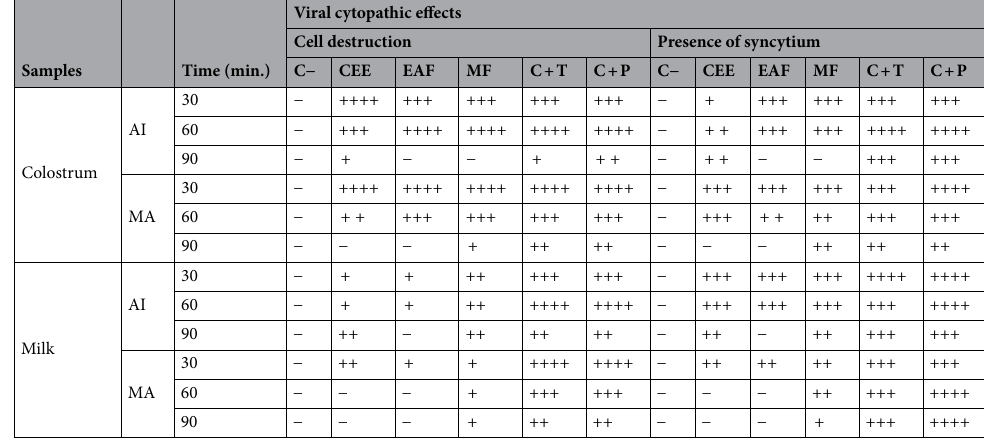
Table 2. Levels of cytopathic effects in ovine third eyelid (OTE) cells after co-culture with somatic cells of goat colostrum and milk (CSC/MSC) treated with crude ethanolic extract (CEE) and the respective organic ethyl acetate (EAF) and methanol (MF) fractions of Azadirachta indica (AI) and Melia azedarach (MA) leaves. C−: negative control (only OTE cells); C + T.: positive control for the treatment (OTE and SCC or SMC cells infected with CLV strain—CAEV CO without the addition of extracts), C + P.: positive slide control (OTE cells infected with CLV strain—CAEV CO ); −: absence of cytopathic effects; +: very light effects; ++: light effects; +++: moderate effects; ++++: intense